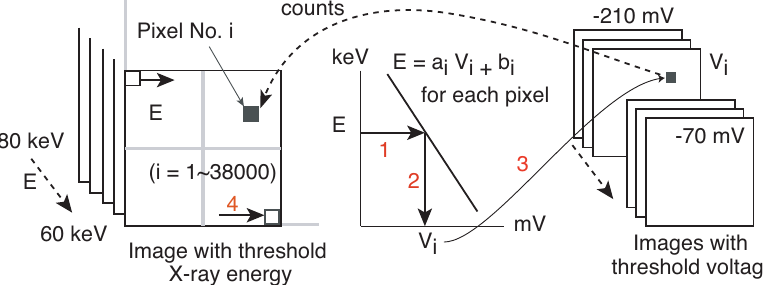
Figure 8. Constructing images by X-ray energy. The equation E = a i V i + b i is determined by the energy E and the pixel No. i , and then the threshold voltage, V i , is determined. The count at pixel No. i is obtained from the image by threshold voltage V i . These procedures are done for each pixel from No. 1 to No.